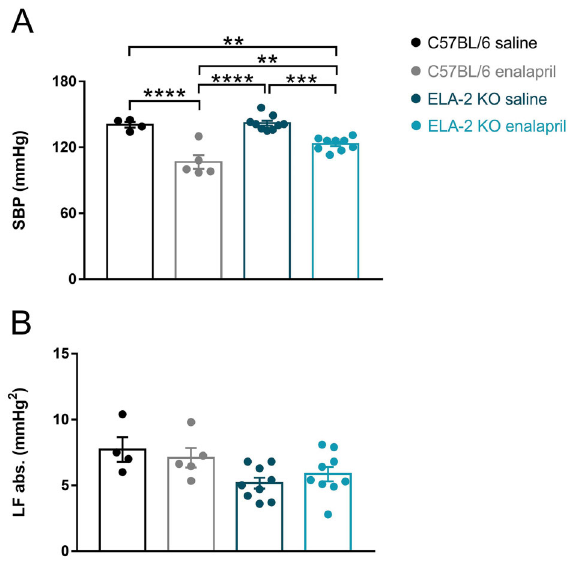
Figure 3. Systolic blood pressure (SBP) and low frequency (LF) band power of knock-out mice (ELA-2 KO) and wild-type mice (C57BL/6) treated with saline or enalapril. A , SBP after 10 days of saline or enalapril treatment. B , SBP low frequency band power. Data are reported as means ± SE. **P o 0.01, ***P o 0.001, ****P o 0.0001, two-way ANOVA. abs: absolute